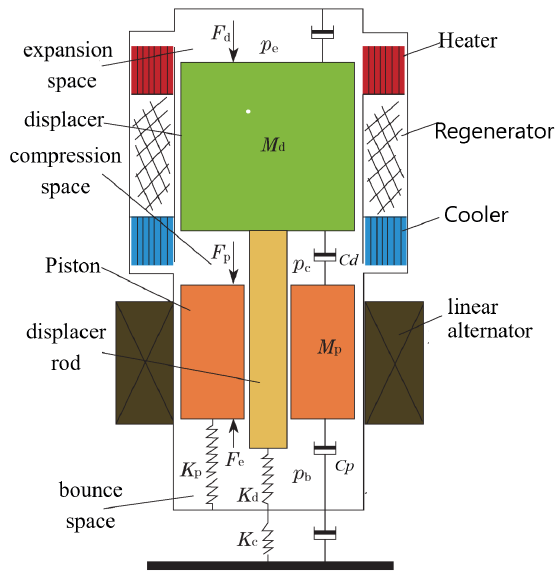
Figure 3. Schematic of the mass-spring-damper model of FPSPC.